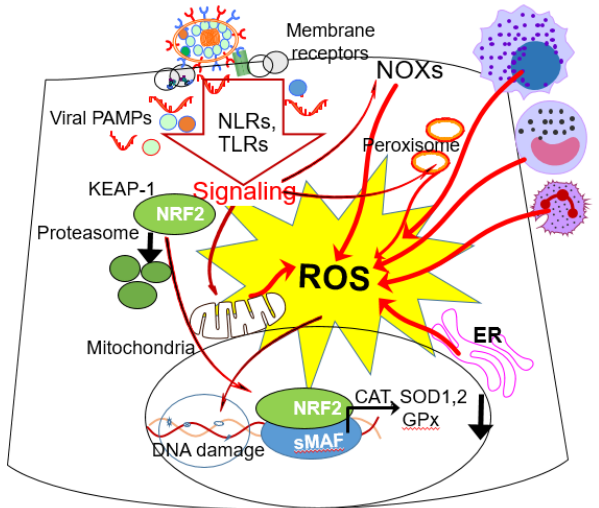
Figure 1. Cellular sources of ROS in respiratory viral infections. Activation of receptors liganded by RSV, influenza and SARS-CoV-2 envelope proteins and the recognition of viral PAMPs by intracellular sensors (NLRs, TLRs) trigger signaling pathways, leading to activation of oxidoreductases located in cell membranes, endoplasmic reticulum, peroxisomes, and mitochondria. NADPH oxidases (NOXs) are the primary enzyme complexes in nearly all cell types, particularly in granulocytes and macrophages, along with oxidoreductases in mitochondrial complex I and II, which partially oxidize oxygen molecules to generate superoxide anion (O 2 •− ). O 2 •− via Fenton and/or Haber-Weiss reactions are converted into hydroxyl radical ( • OH). The highly reactive • OH reacts with proteins, lipids and DNA. ROS themselves, but particularly peroxidation of polyunsaturated fatty acids, trigger nuclear translocation of nuclear factor erythroid 2-related factor 2 (NRF2), which heterodimerizes with small musculoaponeurotic fibrosarcoma (MAF) transcription factor and binds the